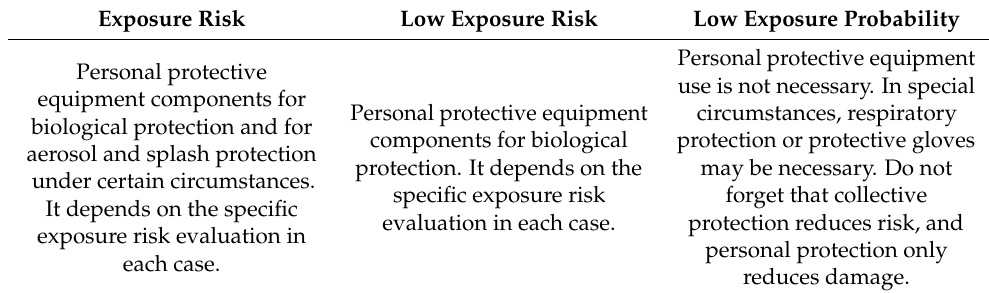
Table 3. Requirements for exposure risk degrees to SARS-CoV-2 in the work environment